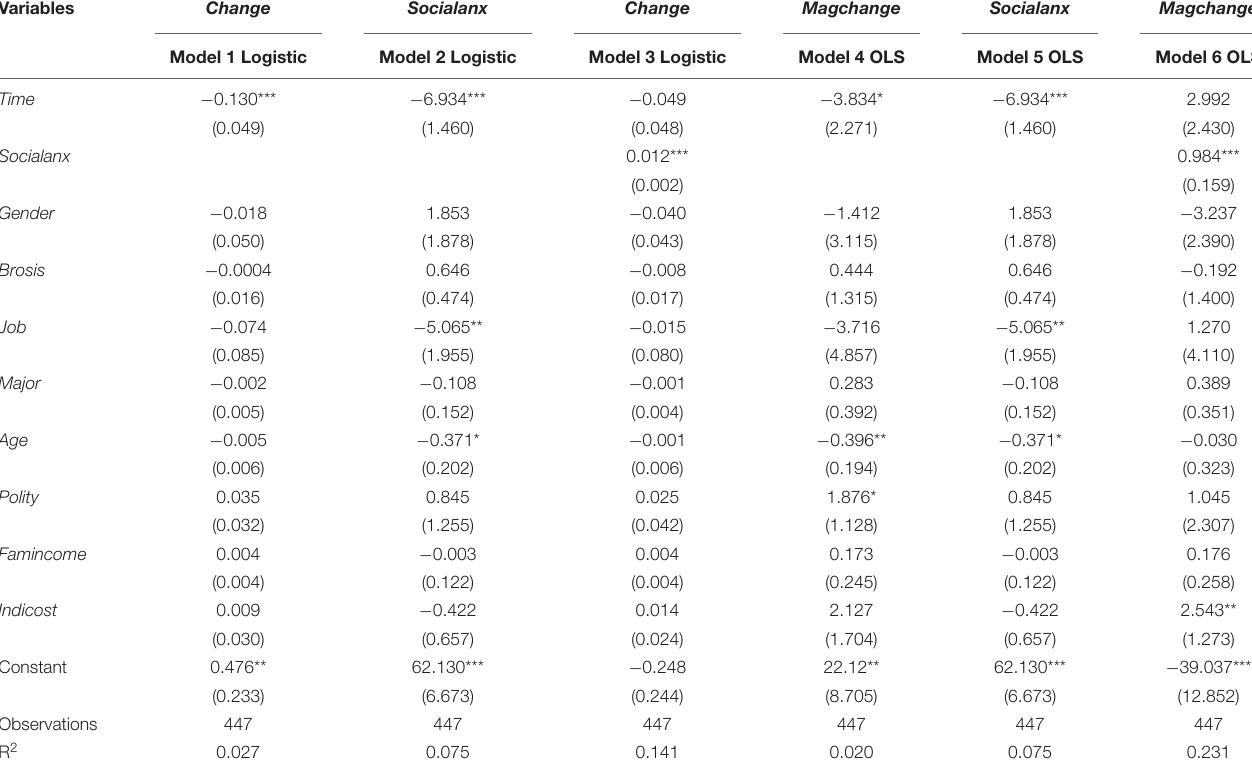
TABLE 7 | Mediating effect of social anxiety in the Positive Donation Condition